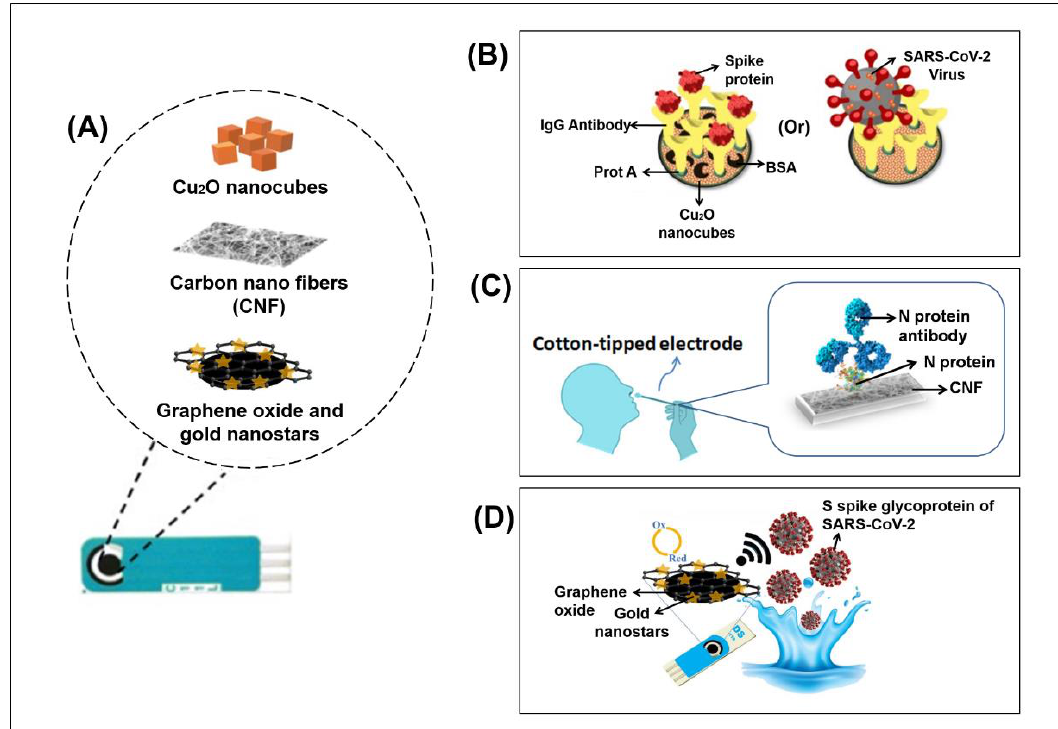
Figure 6. ( A ) Surface modification of screen printed electrodes with nanostructured materials ( B ) Electrochemical im- munosensor with Cu 2 O nanocube coating for the detection of SARS-CoV-2 spike proteins. Bovine Serum Albumin (BSA) is used as a blocking agent. Reprinted with permission from Roushani, M (2021). Copyright 2021 Springer. ( C ) Cotton- tipped electrochemical immunosensor for the detection of virus nucleocapsid (N) protein. Reprinted with permission [91]. Copyright 2021, American Chemical Society. ( D ) Electrochemical diagnostic kit for the detection of SARS-CoV-2 S spike glycoproteins. Glycoproteins can be traced through the oxidation signals of gold nanostars, which are deposited on the surface of the modified electrode. Reprinted with permission [92]. Copyright 2021, Elsevier B.V.